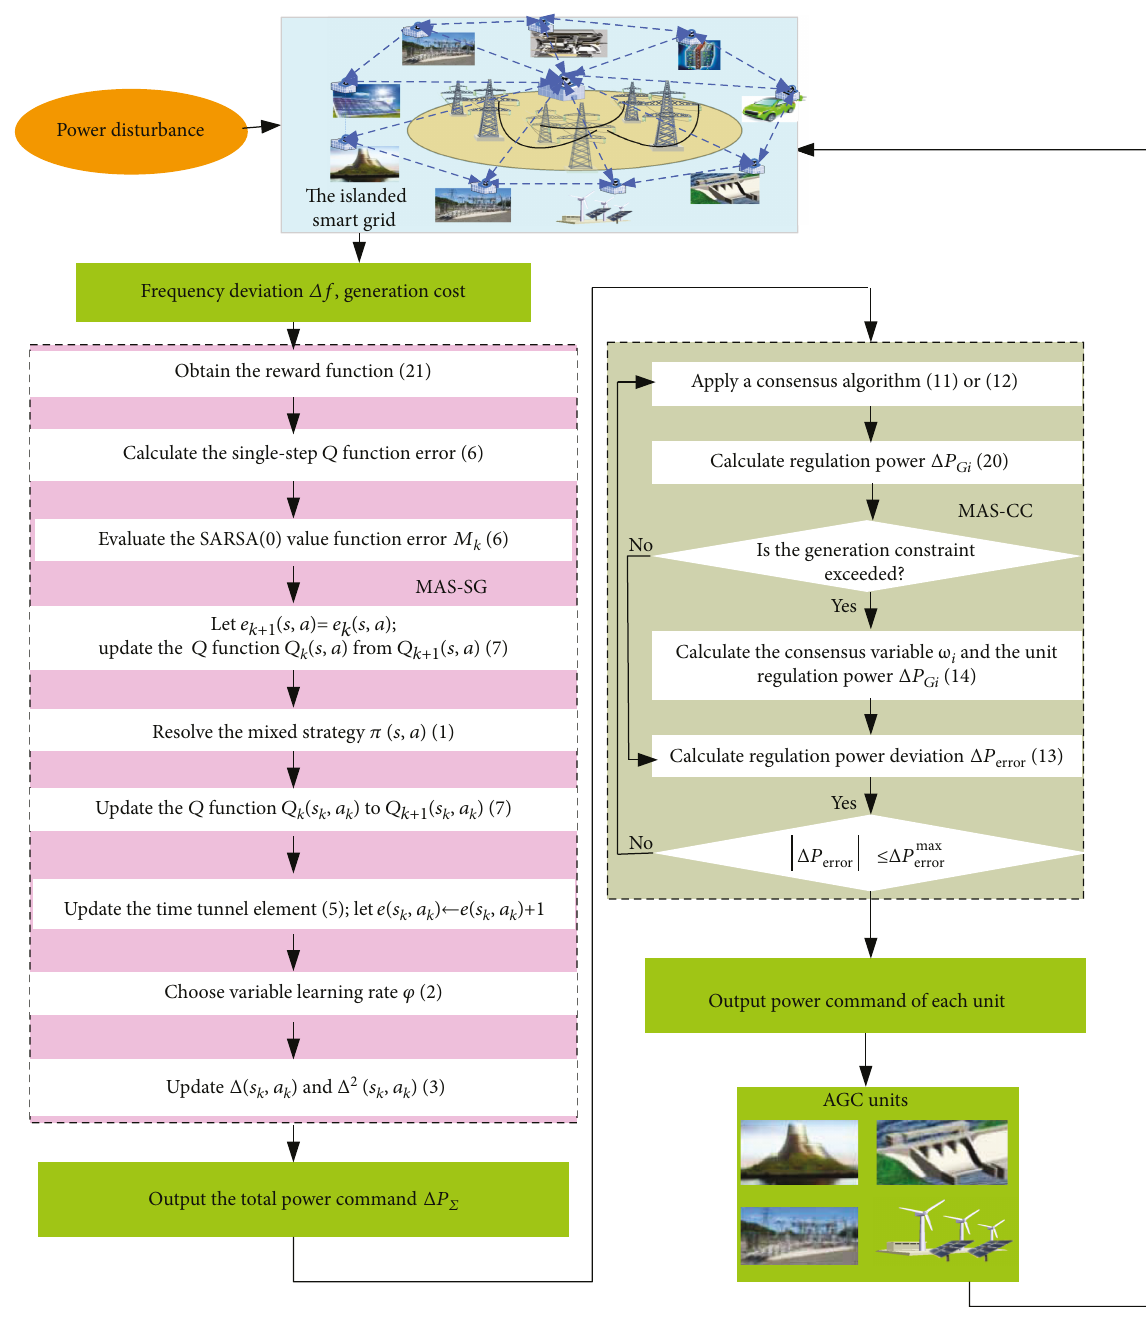
Figure 2: The execution steps of the